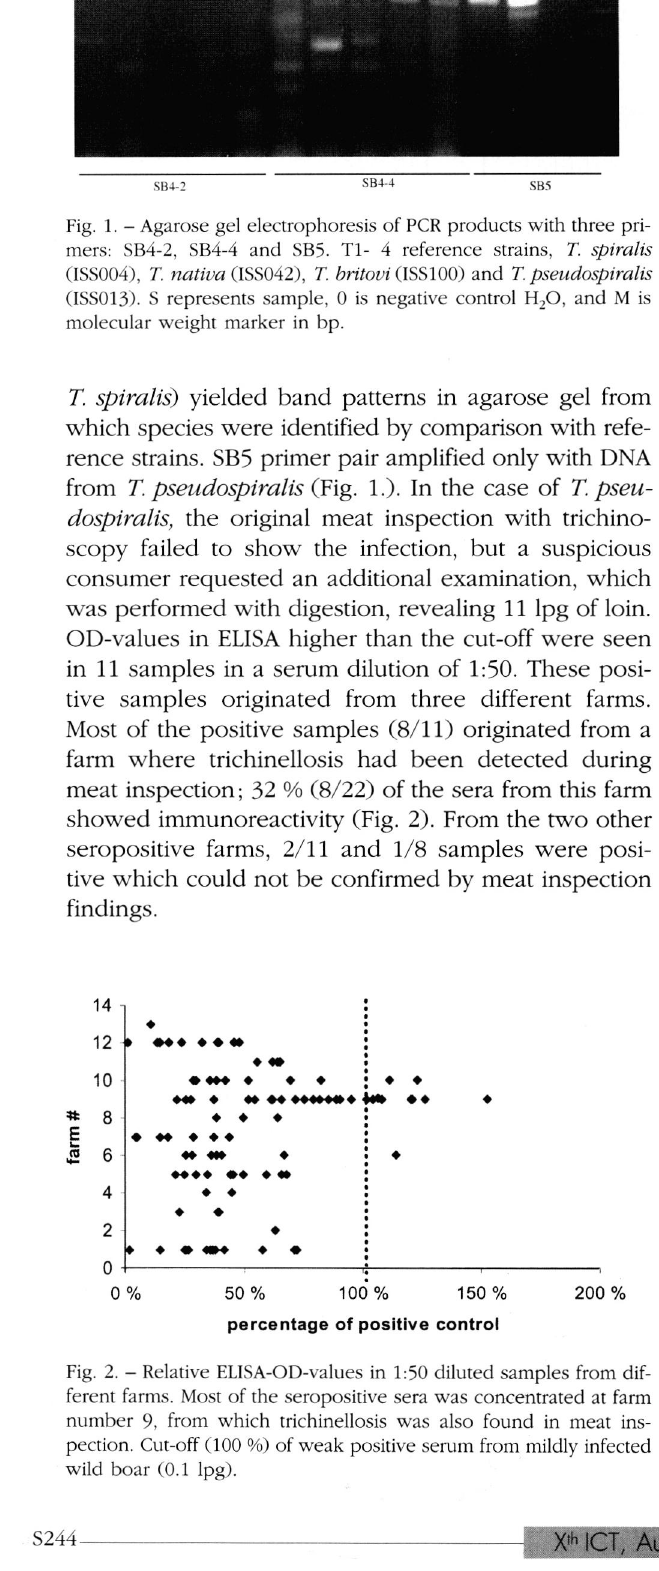
Fig. 2. - Relative ELISA-OD-values in 1:50 diluted samples from dif ferent farms. Most of the seropositive sera was concentrated at farm number 9, from which trichinellosis was also found in meat ins pection. Cut-off (100 %) of weak positive serum from mildly infected wild boar (0.1